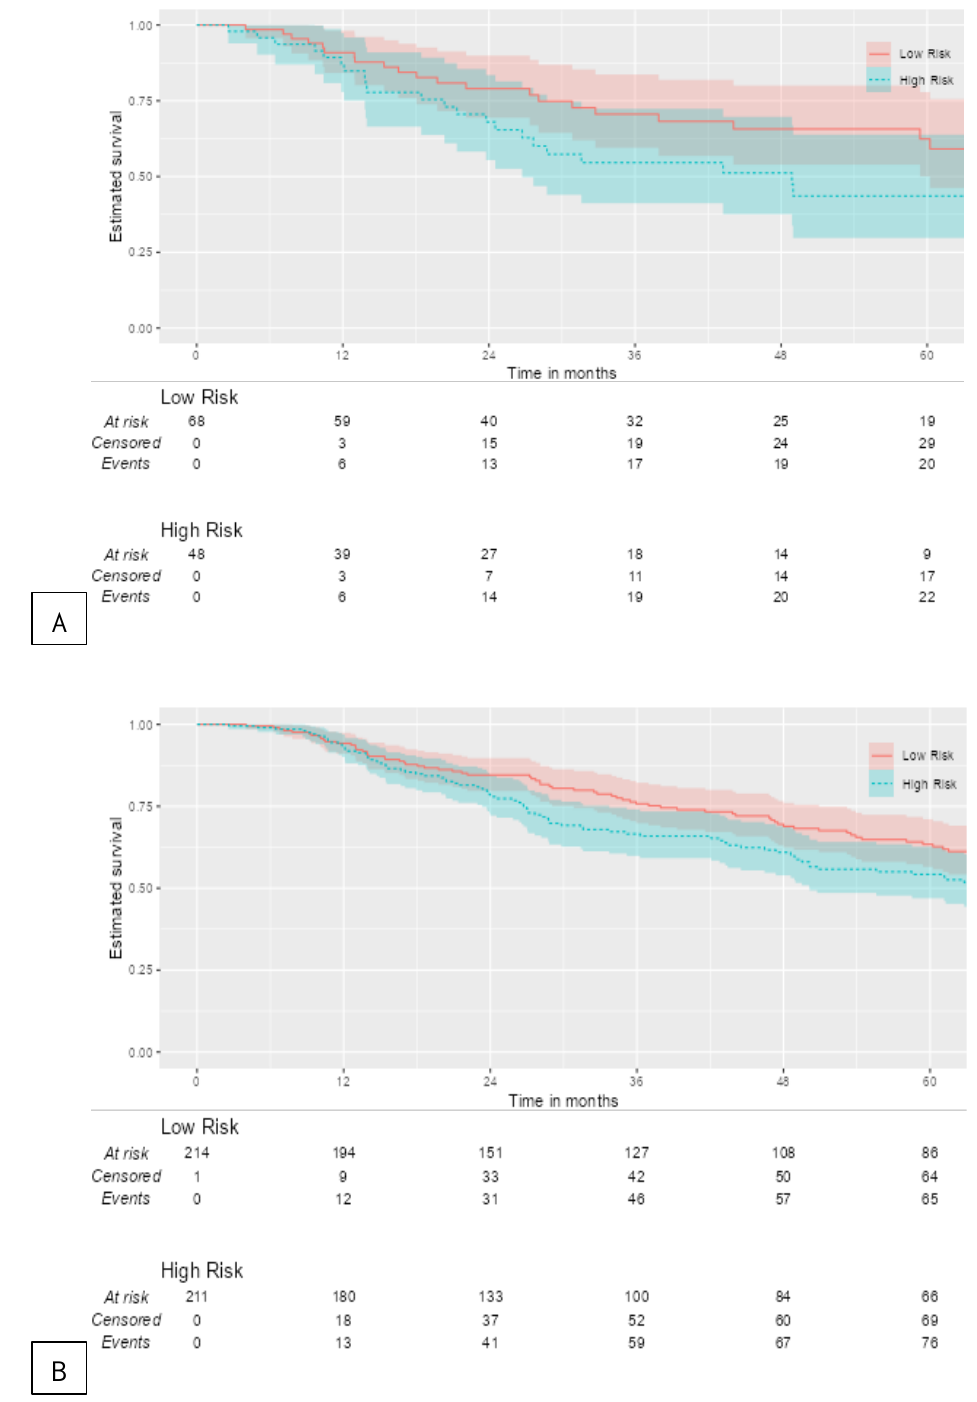
Figure 4. Kaplan–Meier curves for external validation of the 12-gene signature risk score and its survival prognostic performance with ( A ) OS in TCGA melanoma patients with RLN tissue samples (n = 116), and ( B ) OS in the total cohort (n = 426).